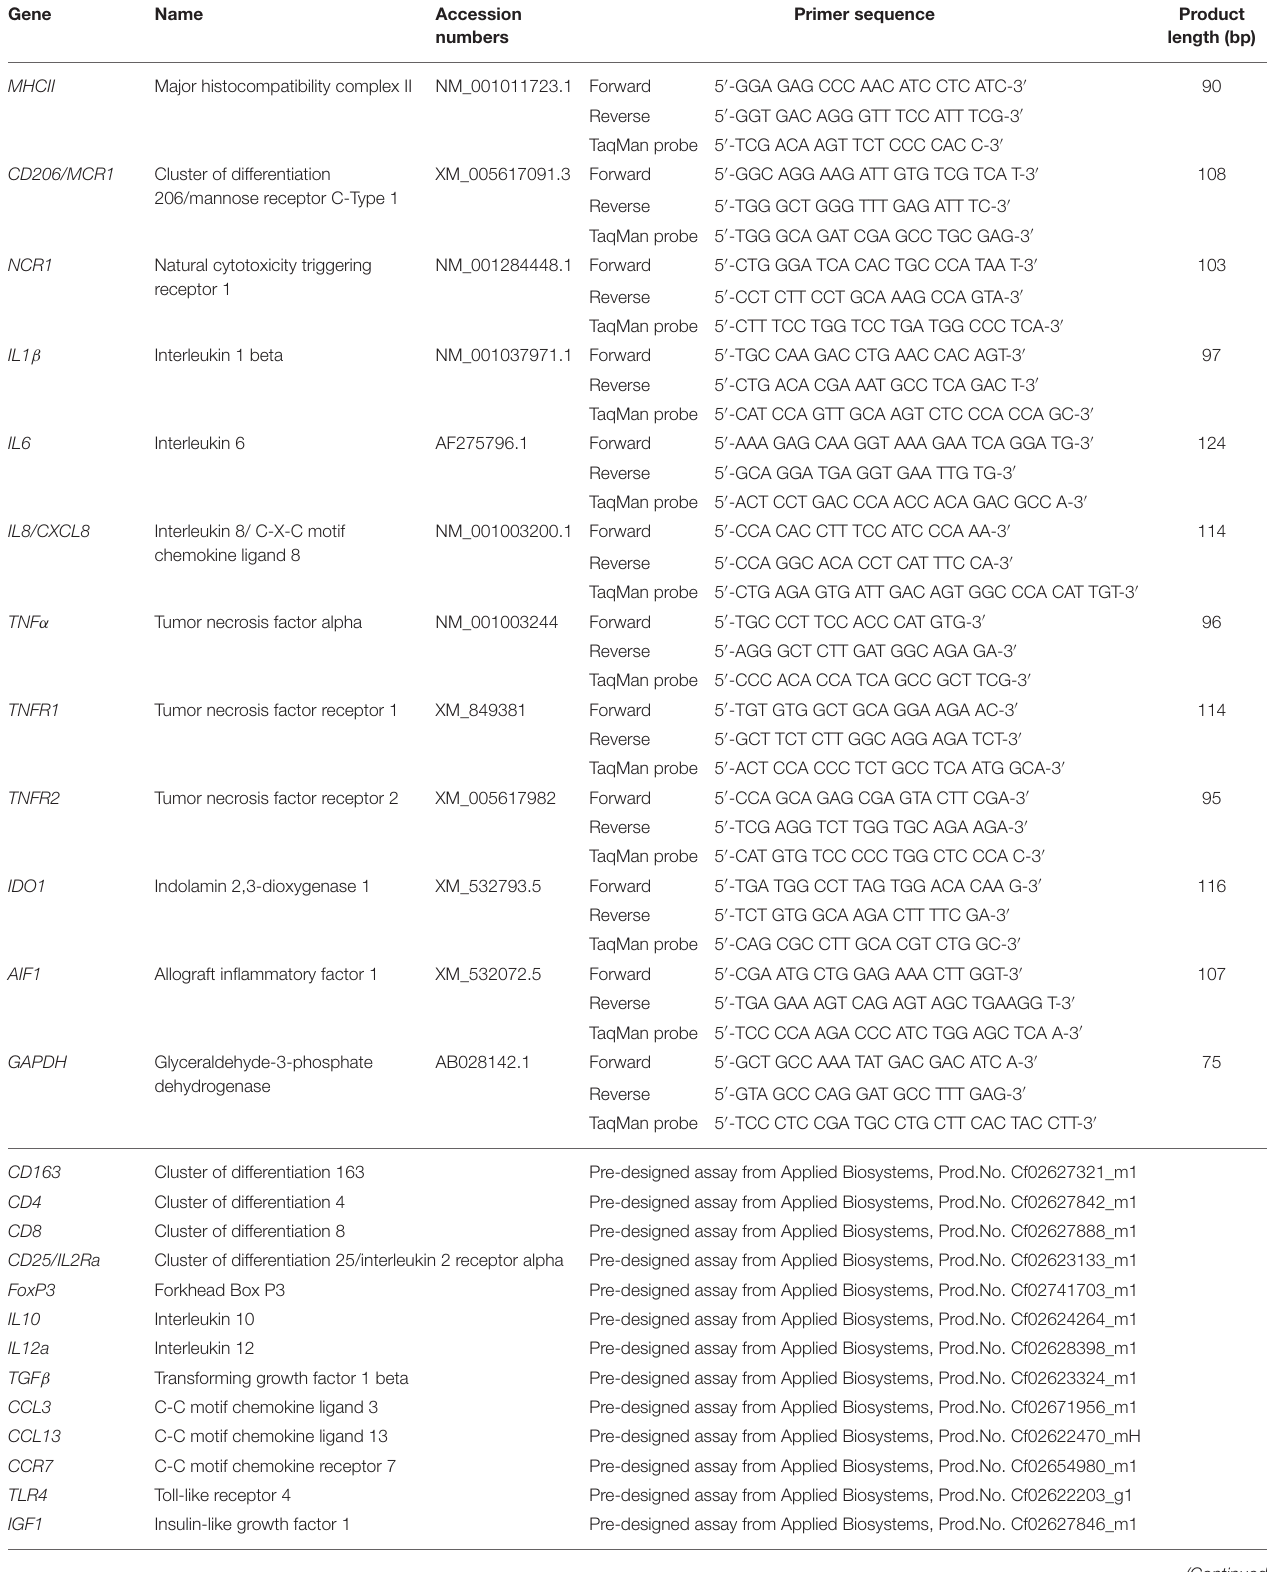
TABLE 1 | List of gene symbols, corresponding gene names, and TaqMan systems used for semi-quantitative real time qPCR.